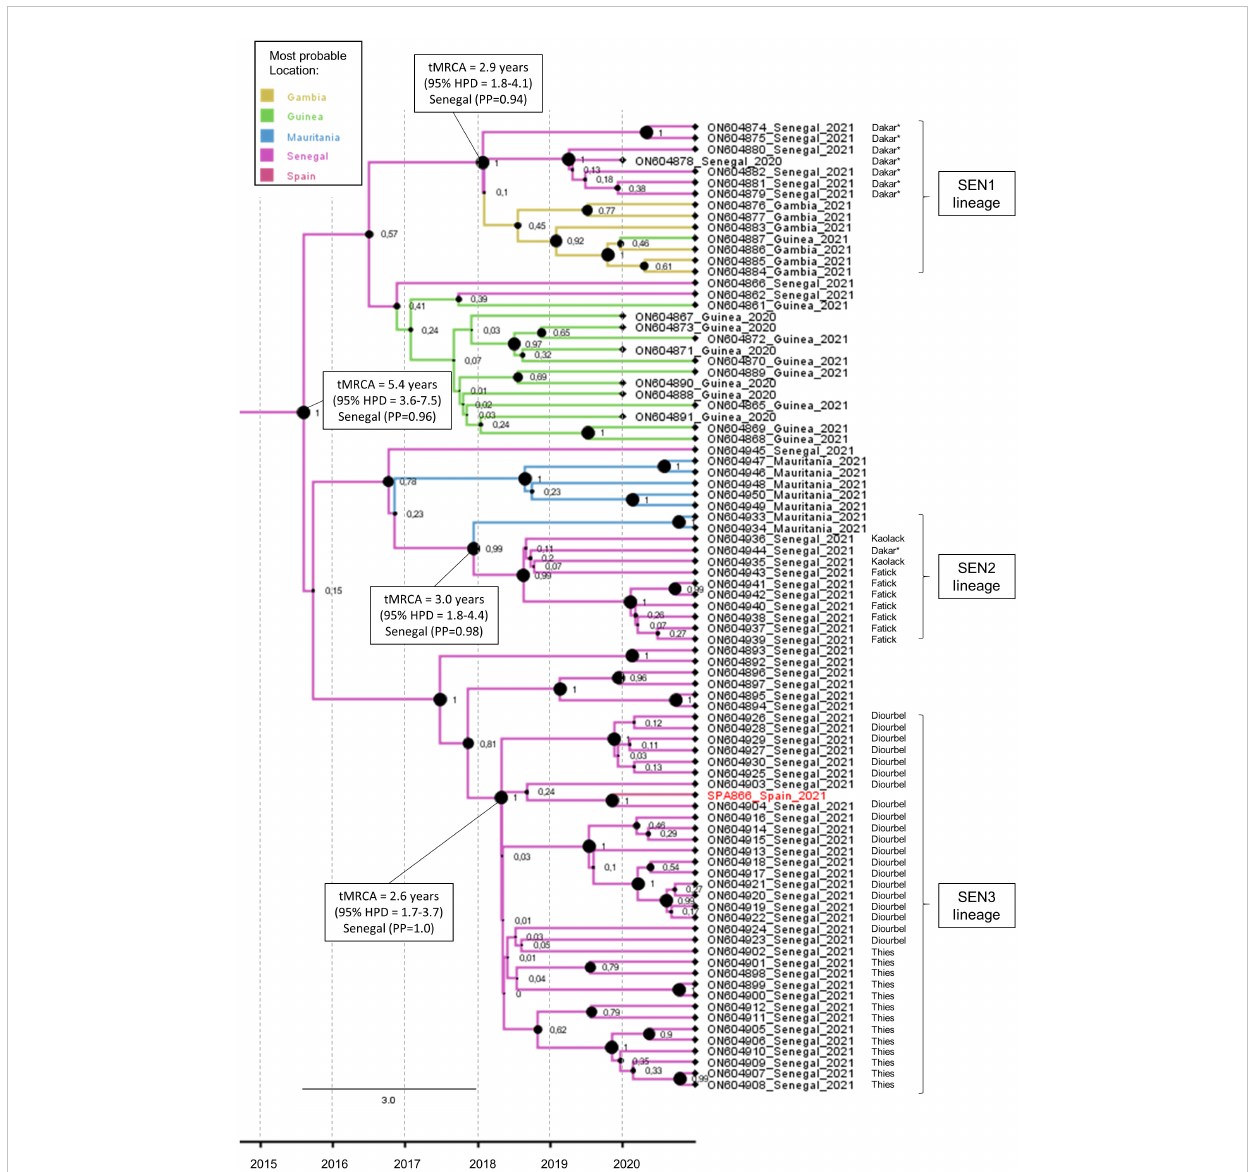
FIGURE 3 Maximum clade credibility (MCC) subtree of the 86 VP1 coding sequences branching with the SPA866 sequence. Branch colors indicate the most probable location of the MRCA. Node support values are indicated by their values and node size. The scale axis represents the estimated dating of the MRCA for each cluster. The regions within Senegal where samples were taken are indicated. Samples from sewage are indicated by an